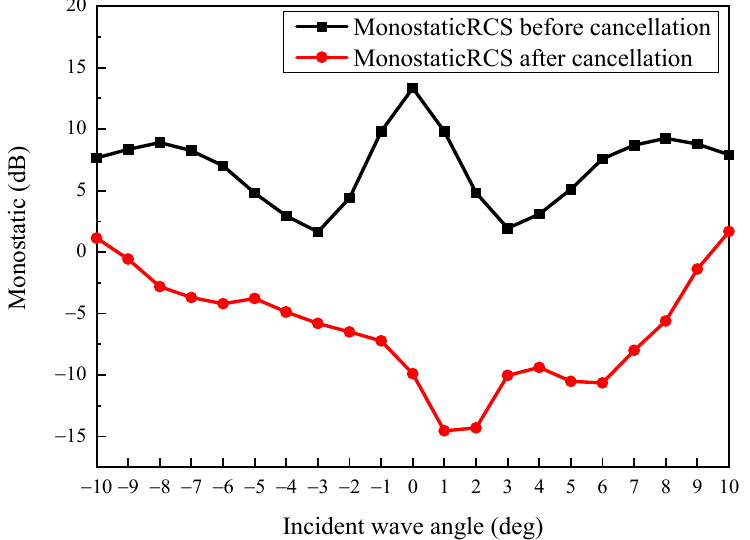
Figure 8. Minimum ARCS for targets with azimuths in the range of − 10 degrees to 10 degrees.